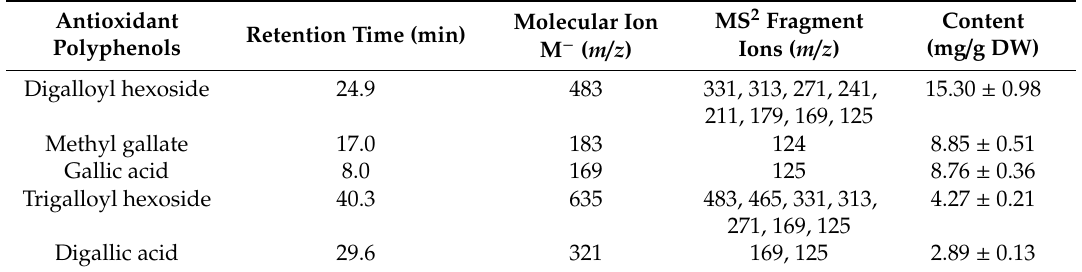
Table 3. The content of main antioxidant polyphenols in red sword bean (RSB) seed coats. Antioxidant Polyphenols